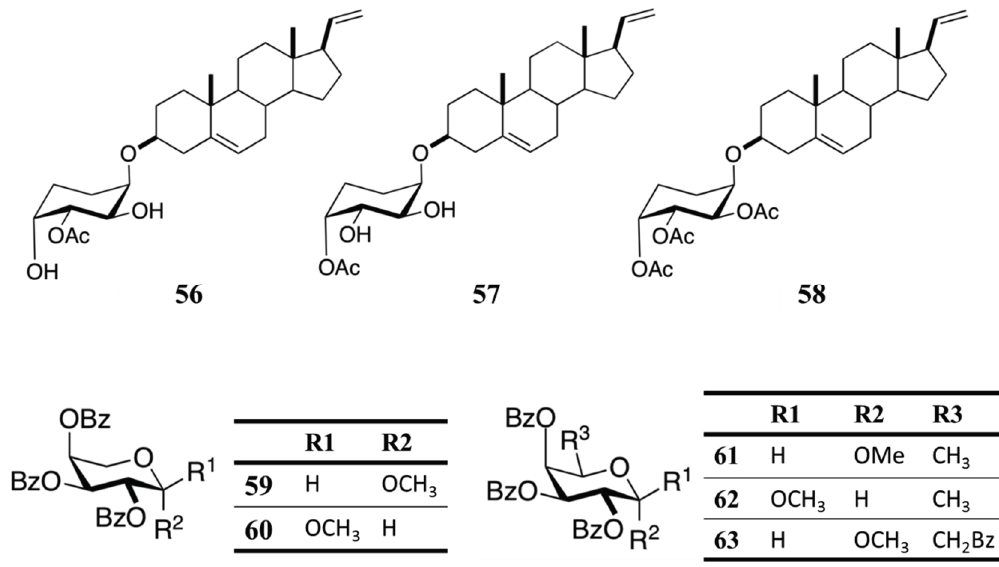
Figure 12. Glycosides 56 – 63 , isolated from octocoral, Muricea austere